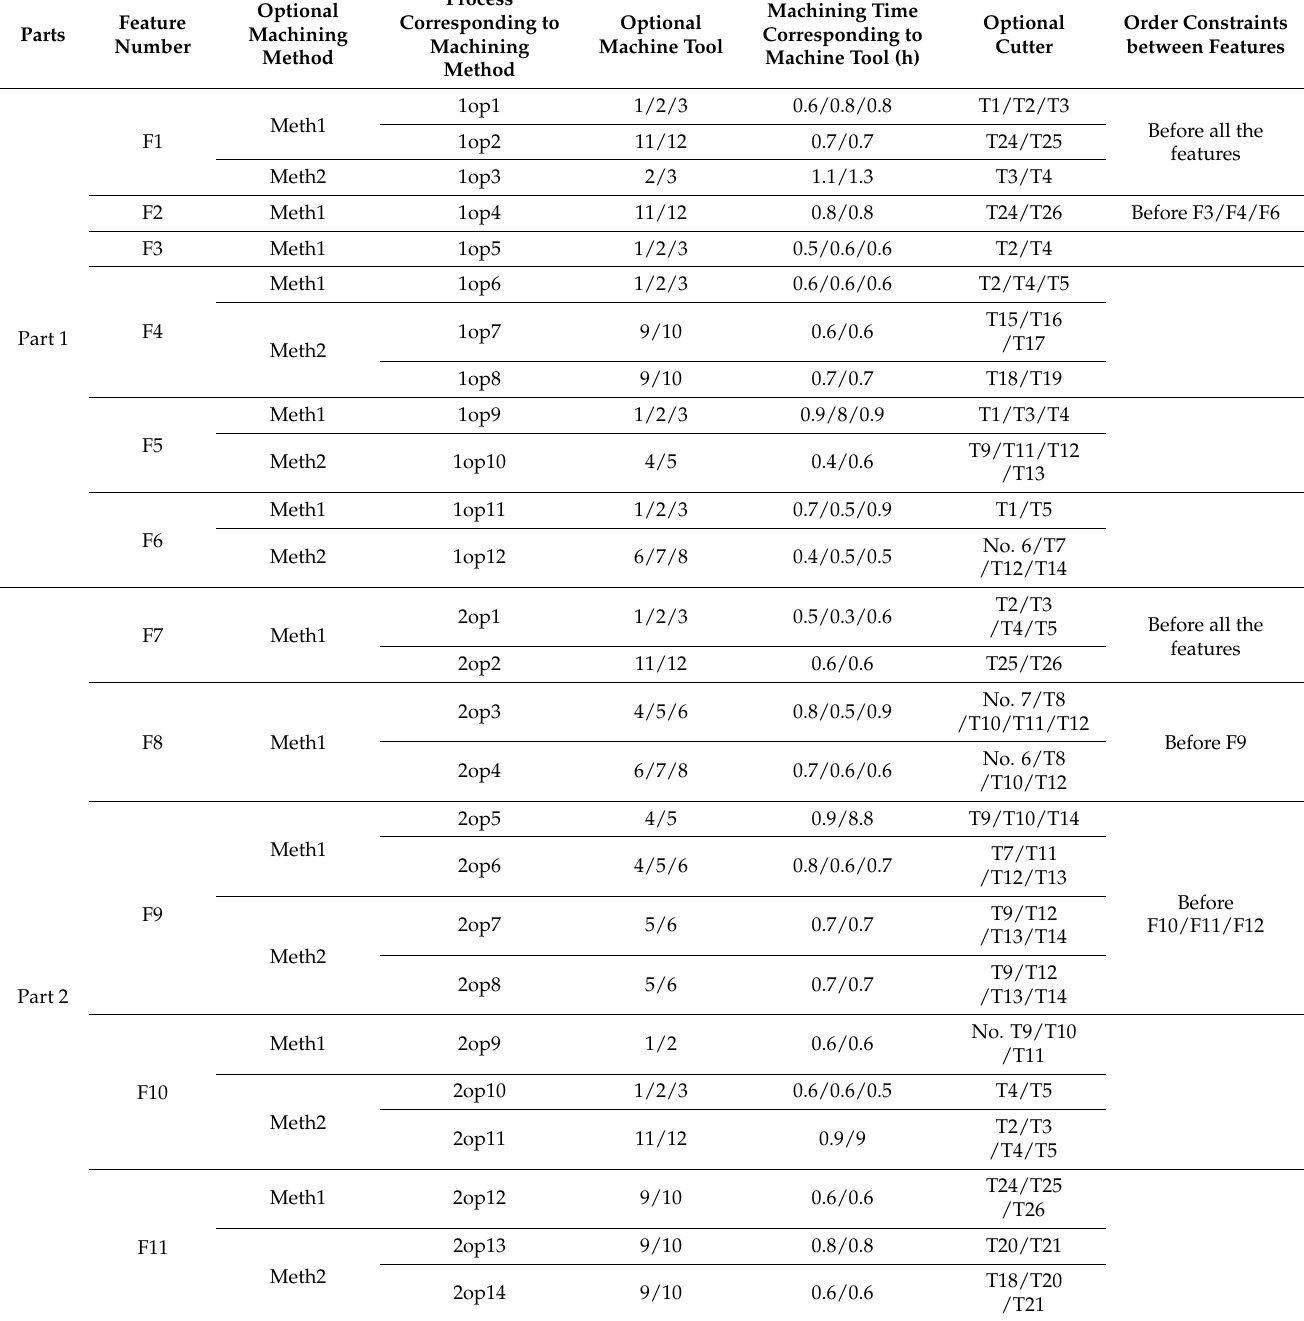
Table 4. Parts’ Processing Technology